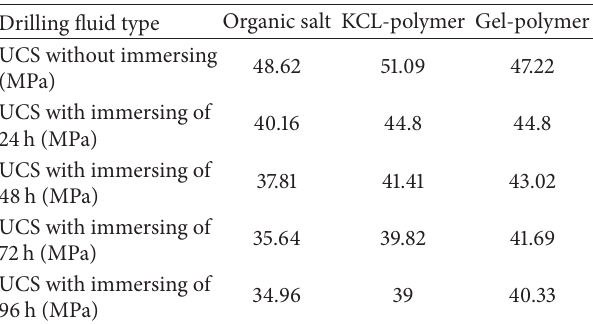
Table 6: Experimental results of shale UCS after immersing in drilling fluid.